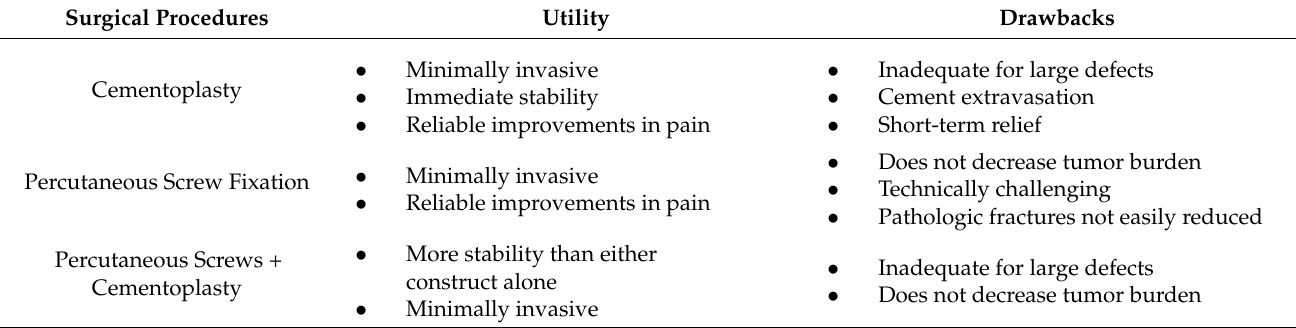
Table 2. Surgical options for management of peri-acetabular metastatic bone disease. Surgical